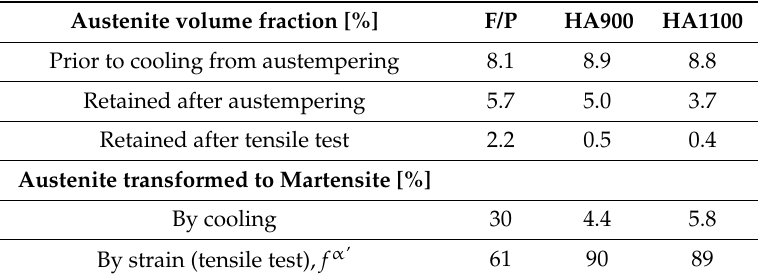
Table 5. Evolution of the amount of austenite due to transformation into